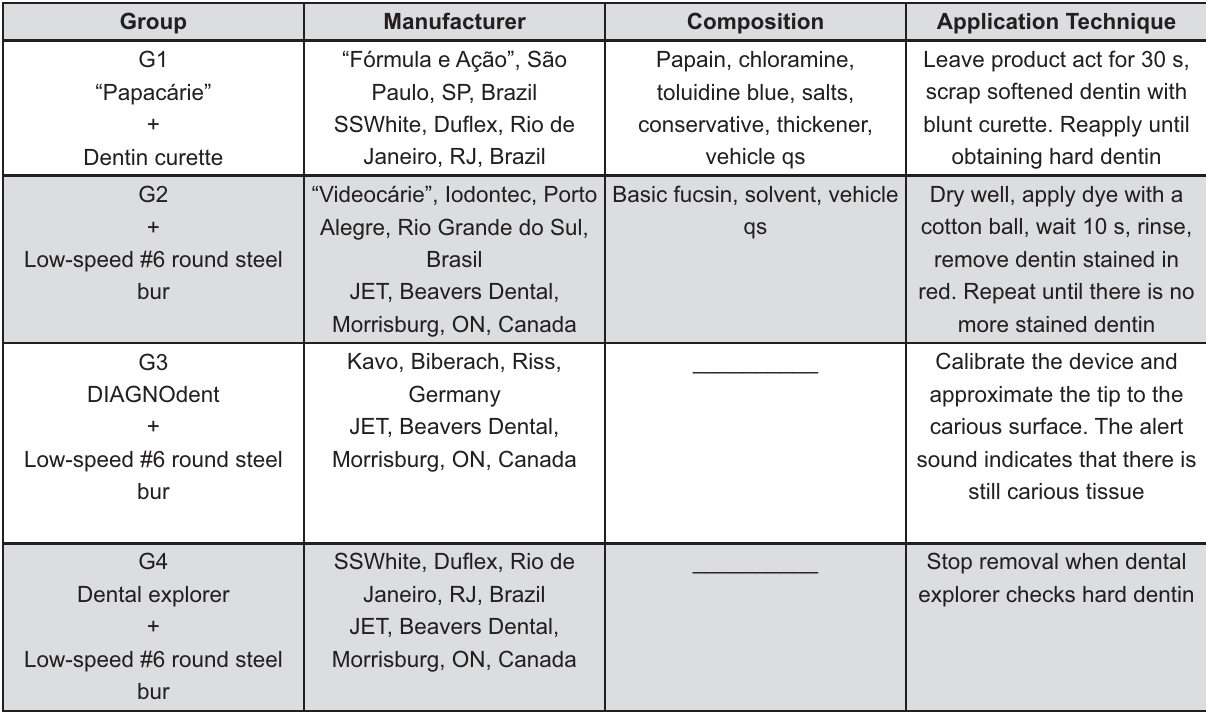
Figure 2- Distribution of groups, composition and manufacturer’s recommendations of use